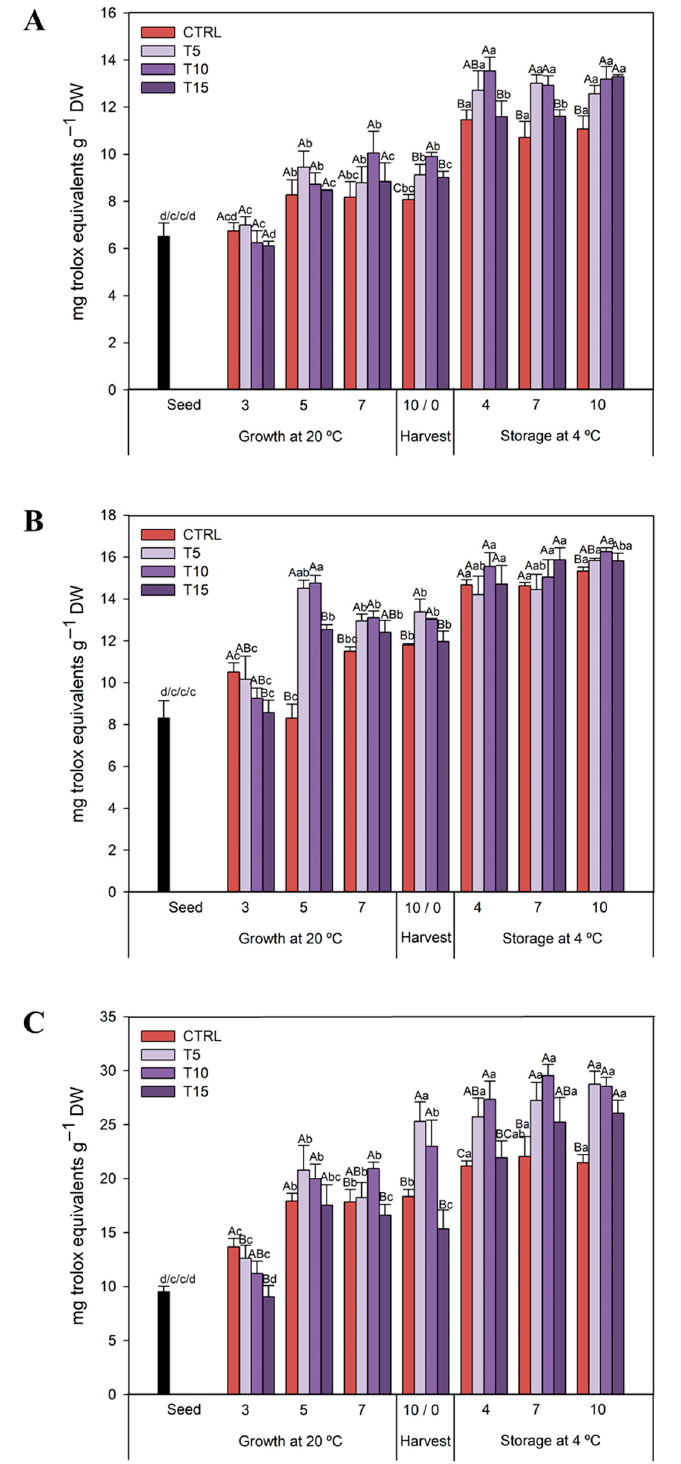
Figure 5. Total antioxidant capacity using the DPPH • ( A ), ABTS • + ( B ), and FRAP ( C ) methods of control (0, CTRL) or UV-B treated (5, 10, and 15 kJ m − 2 ) red cabbage sprouts after 10 days growth at 20 °C and stored 10 days at 4 °C after harvest. Different capital letters indicate significant differences among treatments at p < 0.05 according to Tukey’s test ( n = 6, that were the plates collected, and each plate is a repetition). Different lowercase letters indicate significant differences among time of analysis of the same treatment at p < 0.05 according to Tukey’s test.